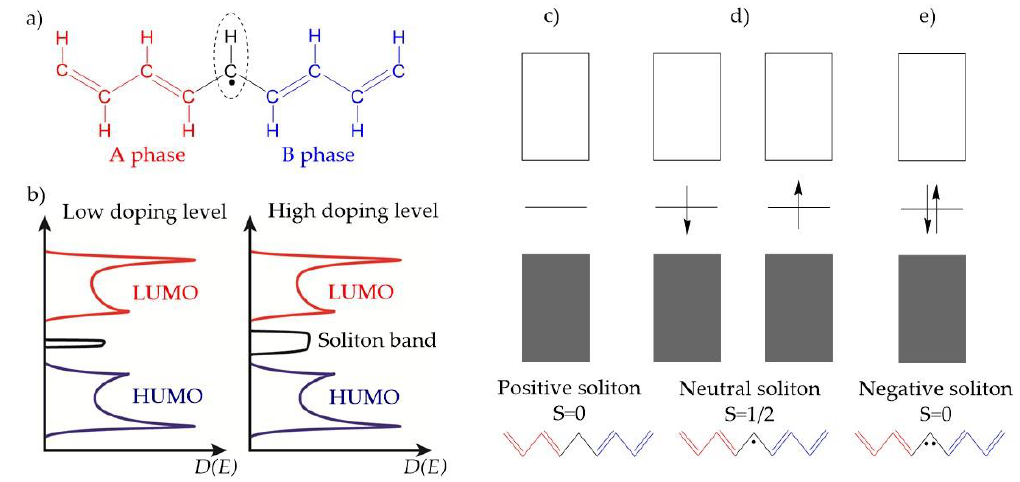
Figure 5. The general conductivity range of conducting polymers (CPs).